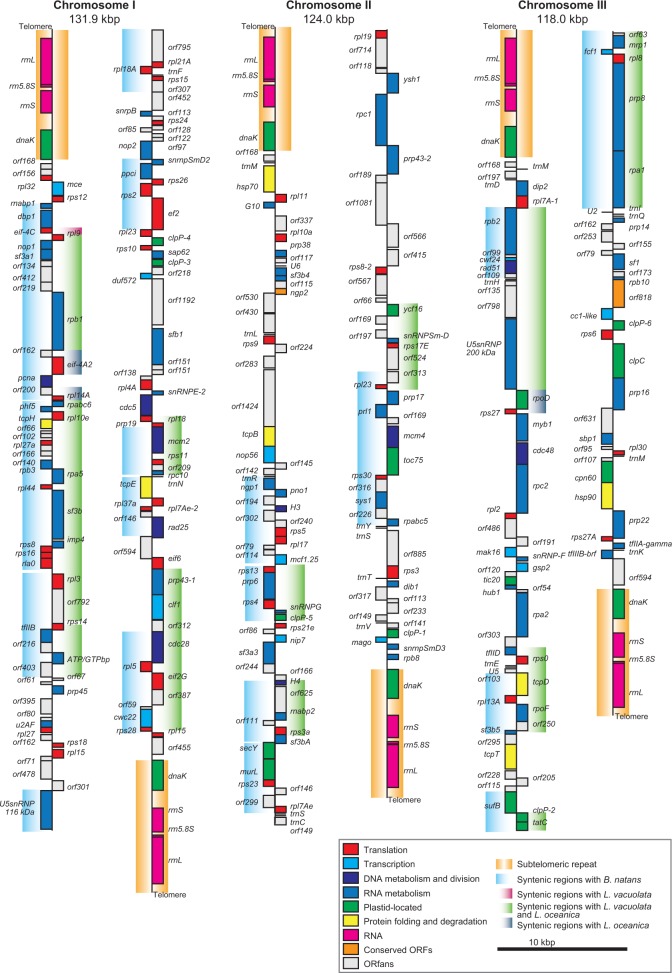
Nucleomorph genome map of the chlorarachniophyte A. amoebiformis. The genome is comprised three chromosomes, which are shown as being artificially broken at their midpoint. Genes indicated on the right side are transcribed from top to bottom, and the genes on the left side are transcribed in the opposite direction. Colors of gene blocks correspond to predicted functional categories in the box. Syntenic regions with B. natans (blue), L. vacuolata (red), L. oceanica (gray), and both L. vacuolata and L. oceanica (green) are shaded by color gradations.